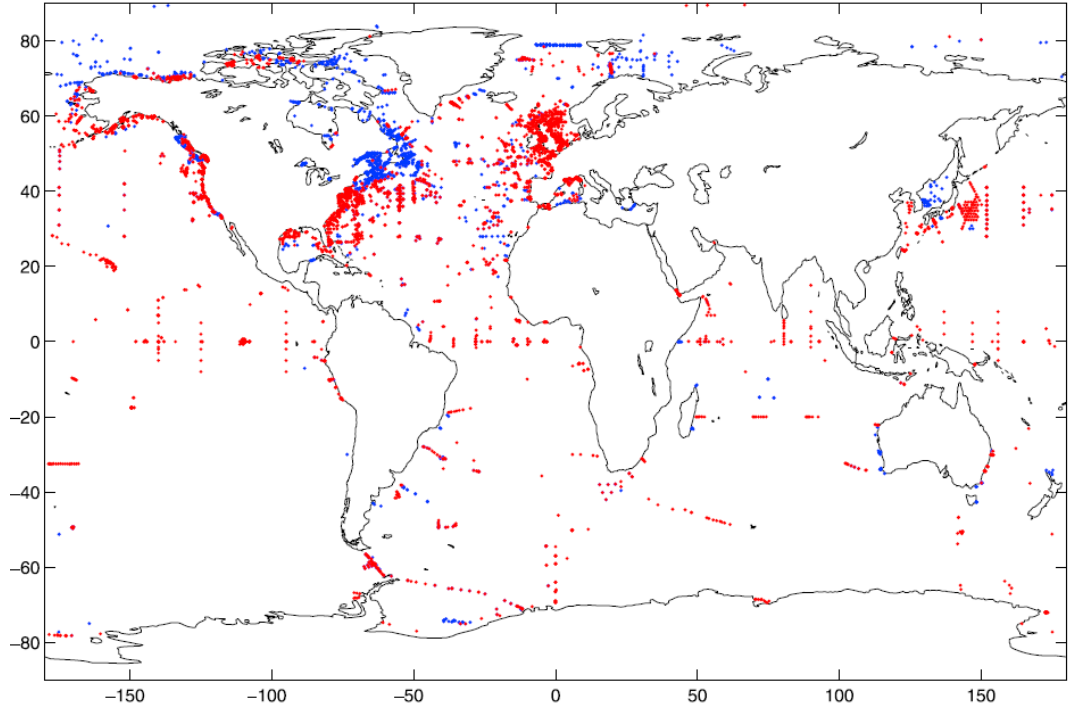
Figure 2. Summary of current observations from moorings and met-ocean buoys. Map available at Woods Hole Institution at http://www. whoi.edu/page.do?pid=68916. Colors indicated the availability of data; see a detailed explanation of data compilation in Holloway